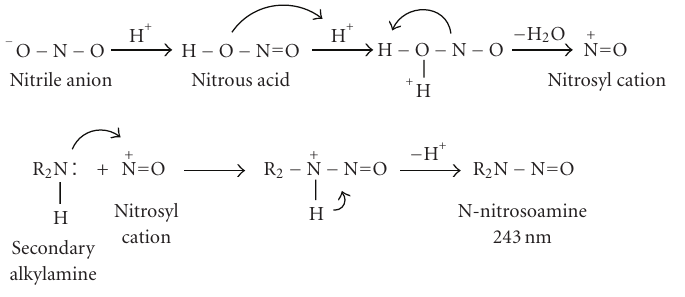
Scheme 1: Scheme showing the conversion of secondary amine to its N-nitroso derivative on treatment with nitrous acid in the presence of